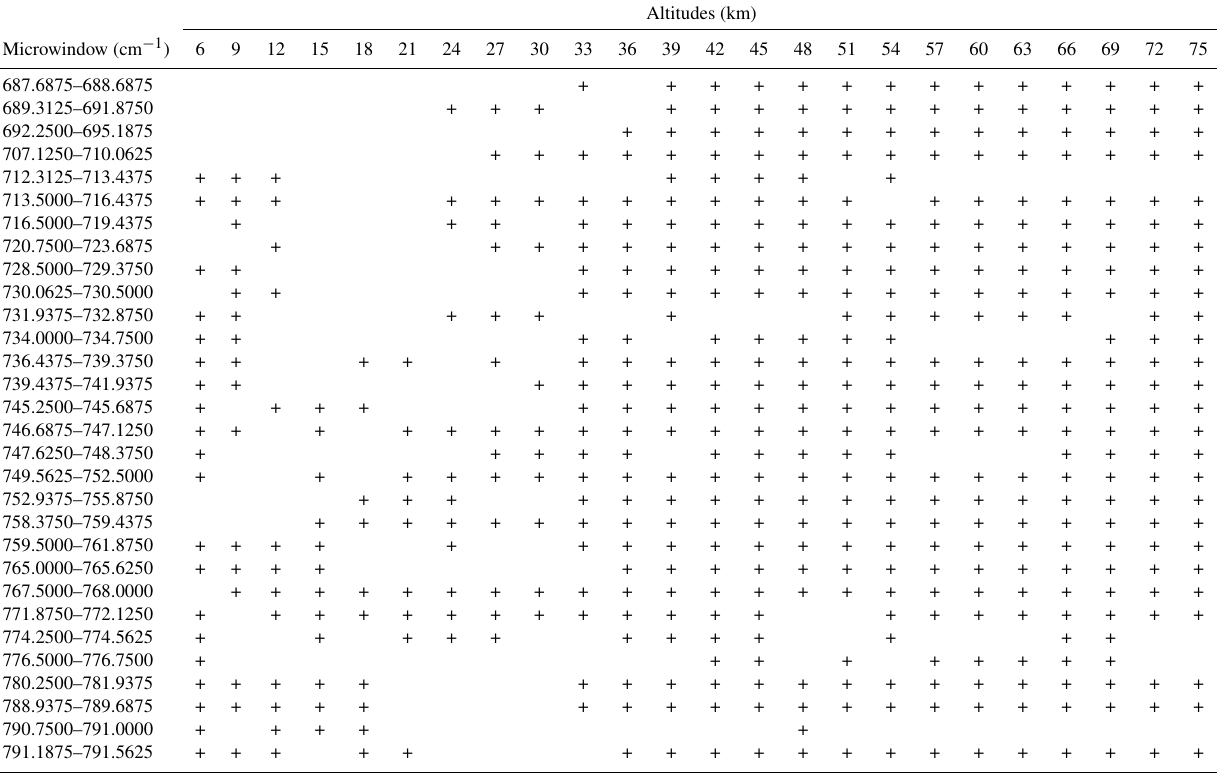
Table 1. Microwindow set used for ozone retrieval in MIPAS channel A. The left column shows the spectral ranges of the microwindows. The plus signs indicate at which heights a particular microwindow is